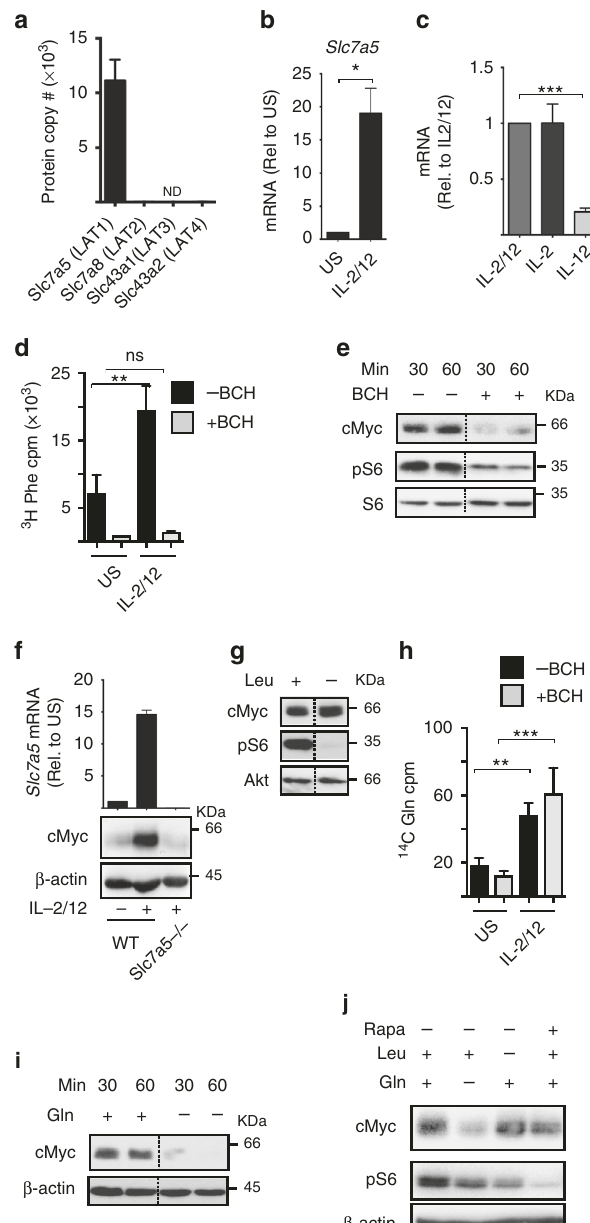
Fig. 4 SLC7A5 activity is required for IL-2/IL-12-induced cMyc expression. a NK cells were activated for 18 h with IL-2/IL-12 and the number of protein copies per cell were determined using quantitative proteomic analysis: SLC7A5, SLC7A8, SLC43A1 and SLC43A2. b NK cells were left unstimulated (US) or were stimulated with IL-2/IL-12 for 18 h and Slc7a5 mRNA levels analysed by qPCR. c NK cells were activated with IL-2/IL-12 for 20 h and then switched into media containing cytokines as shown for a further 8 h. Slc7a5 mRNA levels were analysed by qPCR. d Puri fi ed NK cells were stimulated with IL-2/IL-12 for 18 h and uptake of 3 H-labelled phenylalanine was measured in the presence or absence of the system L competitor BCH (10 mM). e NK cells were stimulated with IL-2/IL-12 for 18 h and the system L blocker BCH (25 mM) was added for the fi nal 30 or 60 min as indicated before immunoblot analysis of cMyc, phosphorylated S6 ribosomal protein on serine 235/6 (pS6) and total S6 ribosomal protein (S6). f Slc7a5 − / − ( Slc7a5 fl ox/ fl ox × Vav-Cre) or WT ( Slc7a5 WT/WT × Vav- Cre) NK cells were left unstimulated or were stimulated for 18 h with